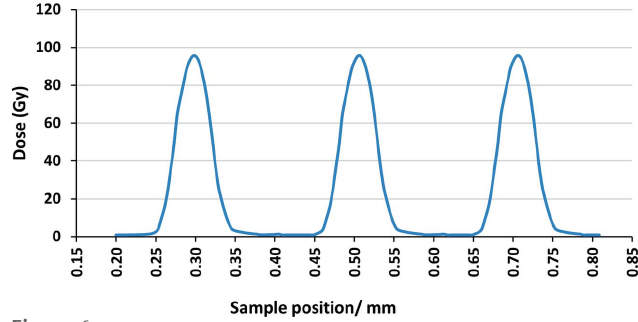
Figure 6 Dose distribution in SMB measured by IMBL PTW microDiamond. The delivered dose was 100 Gy with peak (25 m m) and valley (175 m m).